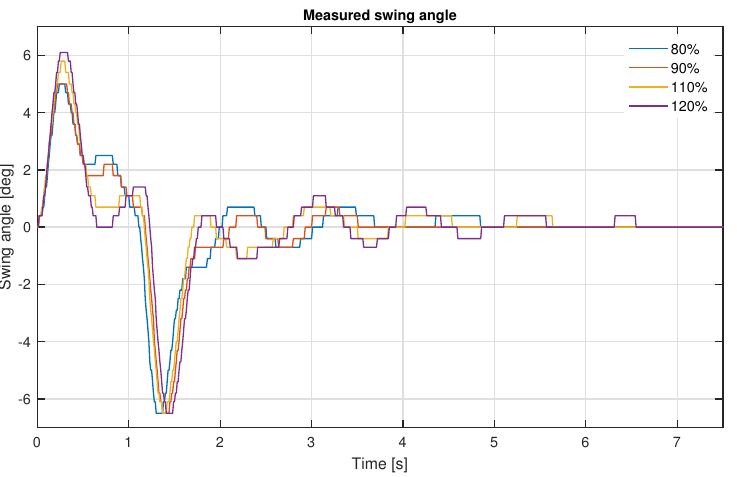
Figure 13. Measured swing angle when the hoist cable length is 80%, 90%, 110%, or 120% of the correct